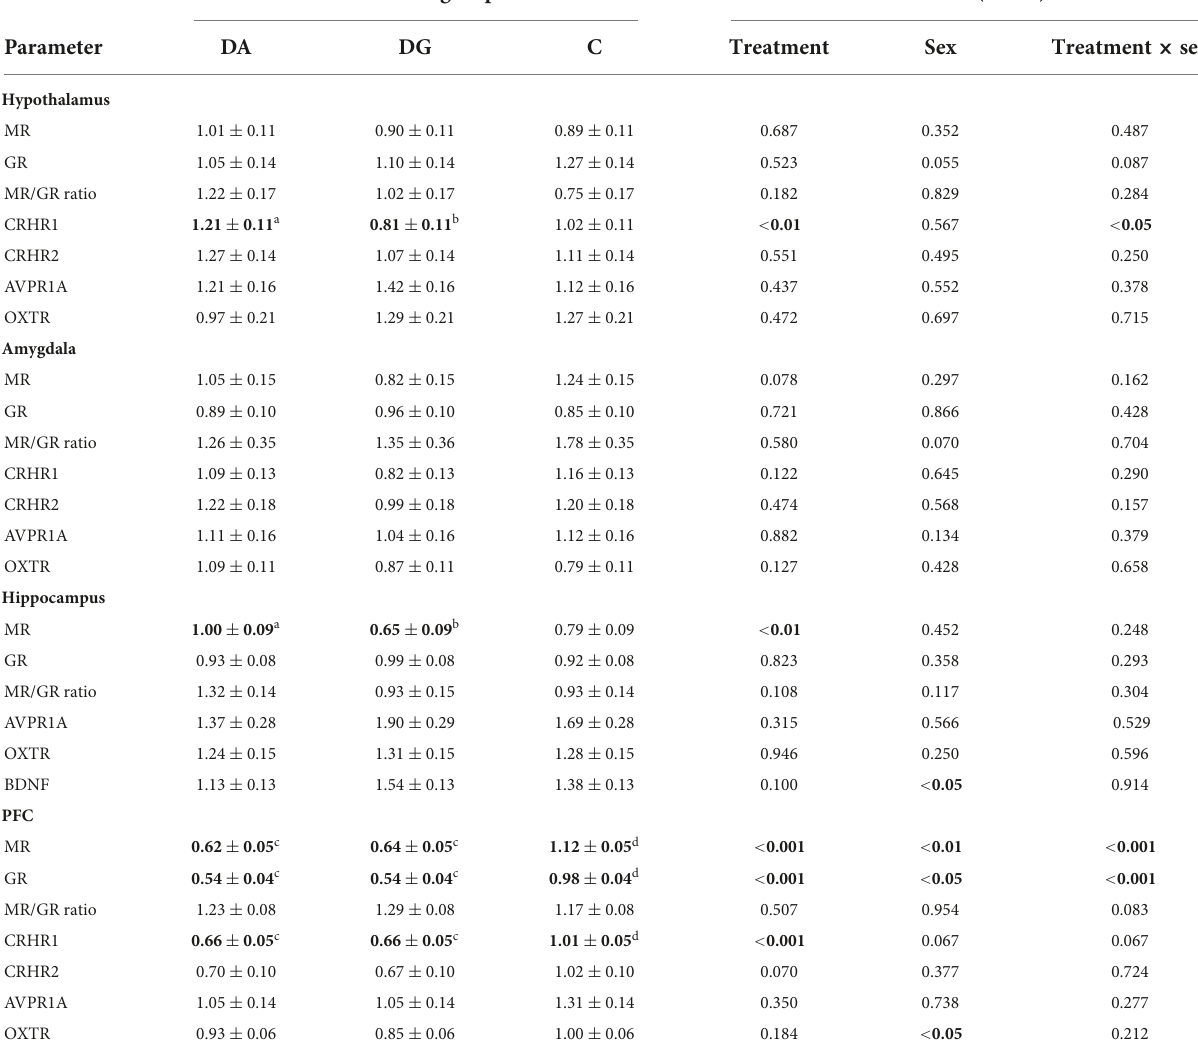
TABLE 4 Relative mRNA expression of HPA-related parameters in the hypothalamus, amygdala, hippocampus and PFC of piglets of the different treatment groups. Treatment